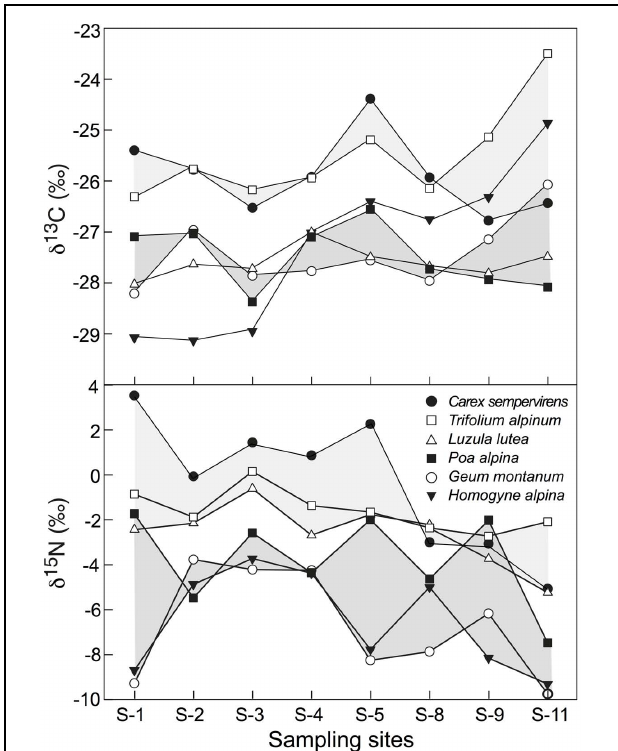
FIGURE 5 | Inter-specific variation in foliar δ 13 C and δ 15 N in six alpine species common to eight sites spread over a 2 km transect at c. 2430–2500 m elevation (Figure 1), with each point representing the pooled signal for several leaves sampled from 5 individuals per species and site. Shades are visualizing distinct high or low signal groups, with δ 13 C in Homogyne not matching any